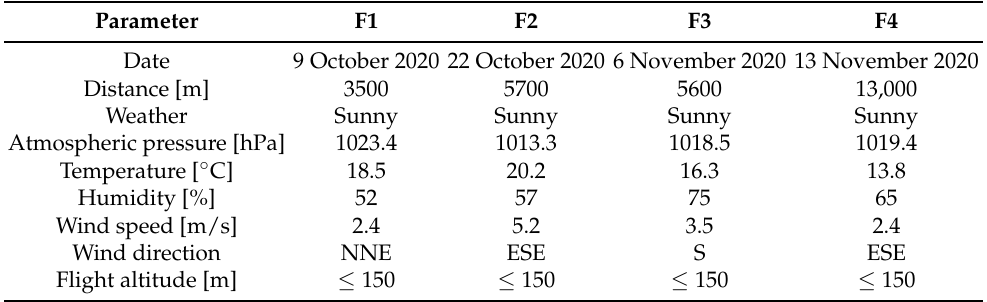
Table 6. Experiment dates, distances, and meteorology information of respective sections.